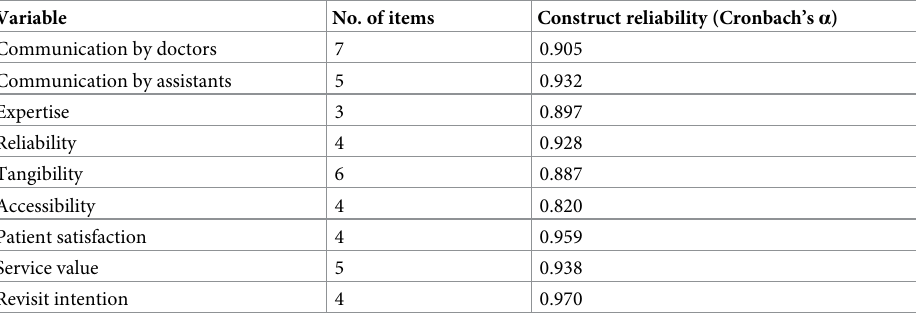
Table 3. Reliability